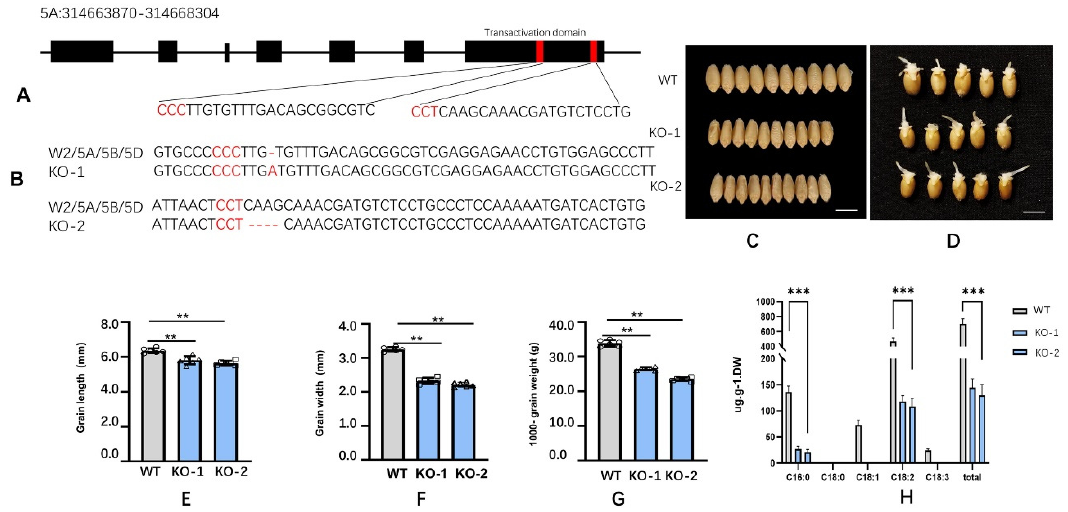
Figure 6. Phenotypes of wheat TaWRI1L2 knock-out mutants. ( A ) The location of gRNA. ( B ) The edited sites of the KO mutants. ( C ) Mature grains and their generation of WT and KO mutants. Bars = 5 mm. ( D ) Generation of WT and KO mutants. Bars = 5 mm. ( E ) The grain lengths of WT and KO mutants. n = 3. ( F ) The grain widths of WT and KO mutants. n = 3. ( G ) The 1000 grain weight of WT and KO mutants. n = 3. ( H ) Grain fatty acid components of WT and its KO mutants. Data in ( C , D ) are represented as means ± SD from independent biological replicates, and p -values are indicated by Student’s t -test (** p < 0.01, *** p < 0.001).